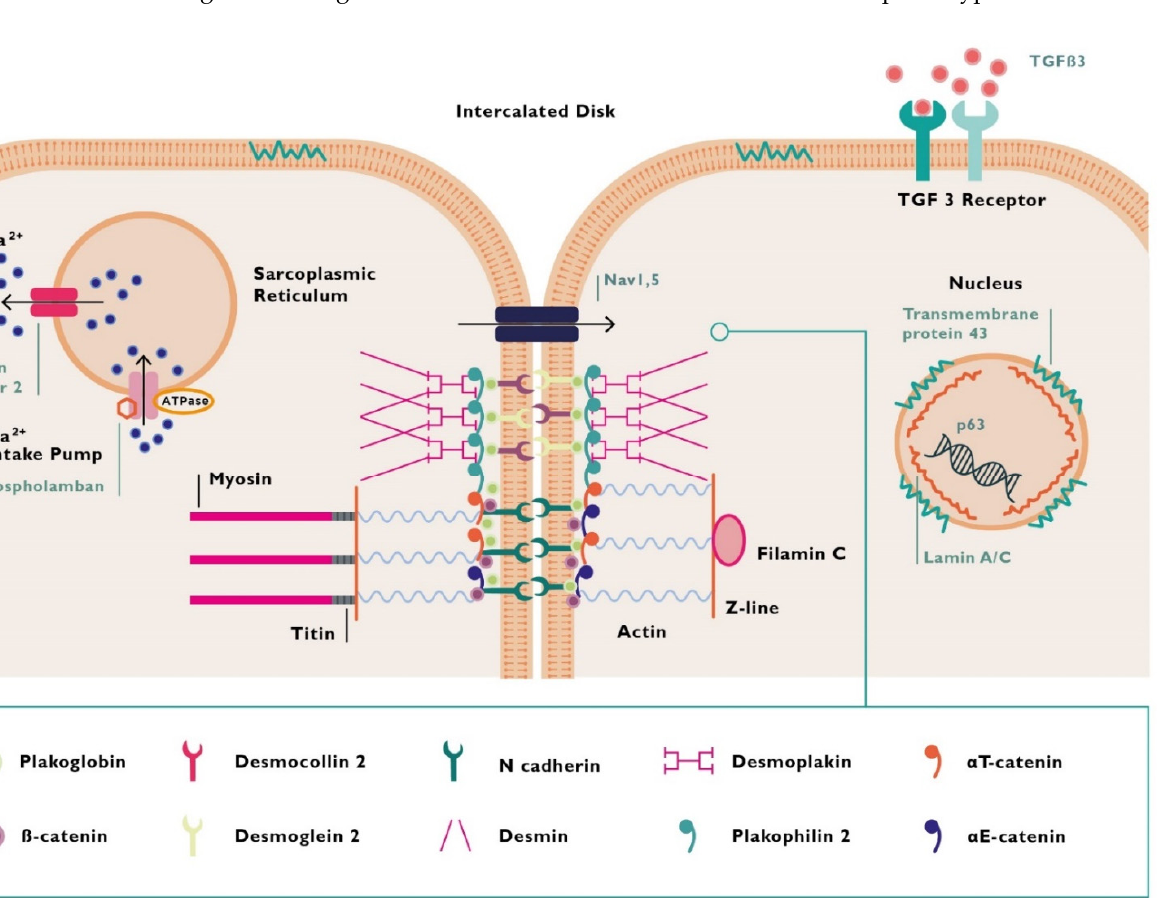
Figure 3. Proteins encoded by mutant genes in arrhythmogenic cardiomyopathy. TGFB3 = transforming grow factor beta 3.